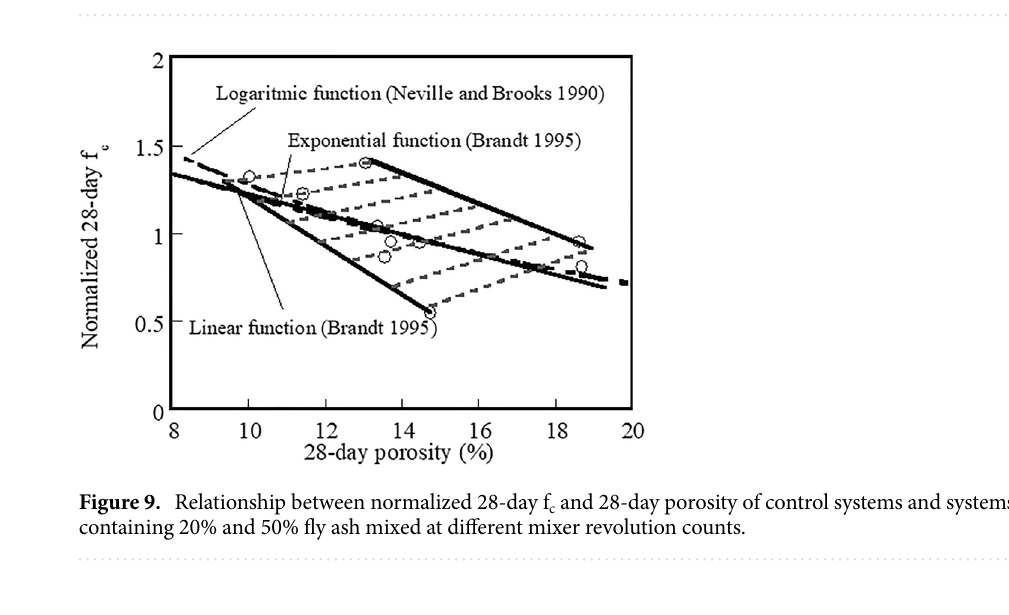
Figure 8. Effect of ( a ) mixing time and ( b ) mixer revolution counts on 28-day porosity of control system and systems containing 20% and 50% fly ash.